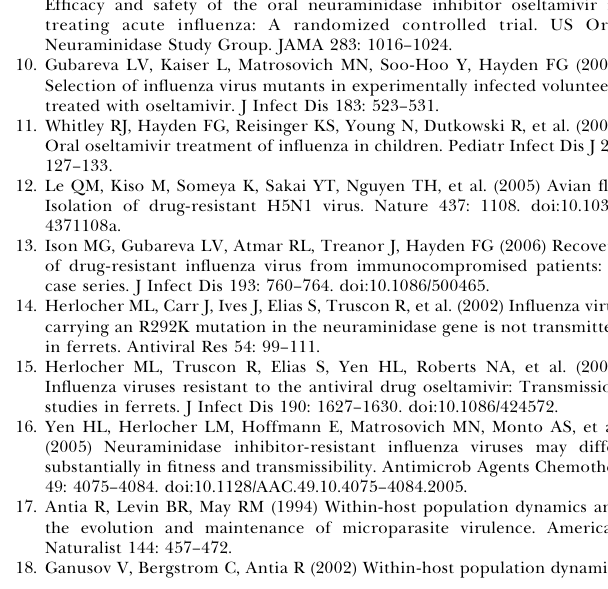
Figure 7. Generation of Resistance for the IR Model Shown are results for the model without ( R t component for both the stochastic and the deterministic simulations. Unless varied, treatment starts 24 h post-infection, the fitness cost is c ¼ 0.1, antiviral efficacy is a ¼ 0.97, and the mutation rate is l ¼ 10 (cid:2) 5 .